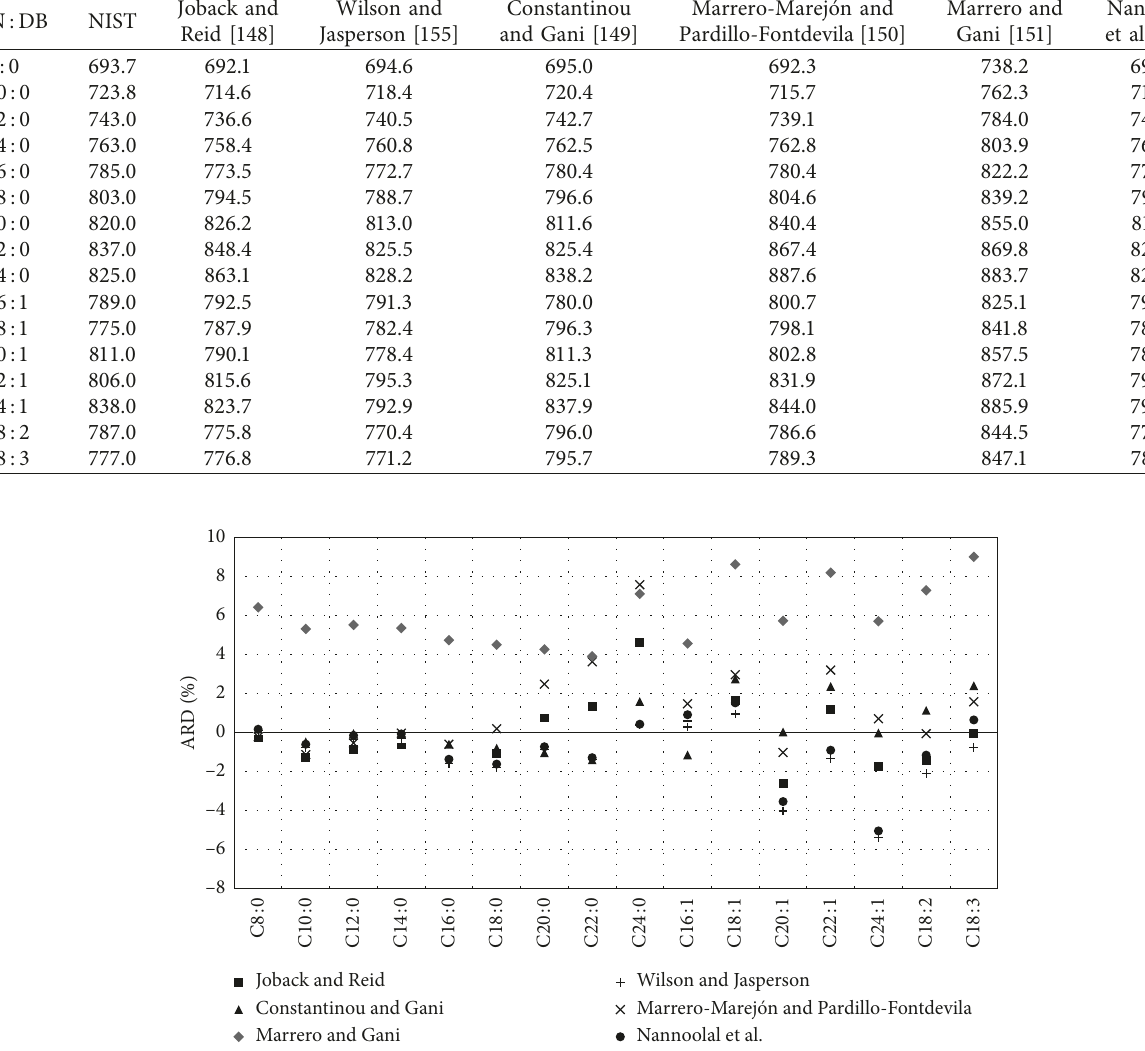
Figure 6: Absolute relative deviation of estimation for the critical temperature. Table 13: Deviations of different methods for the estimation of the critical